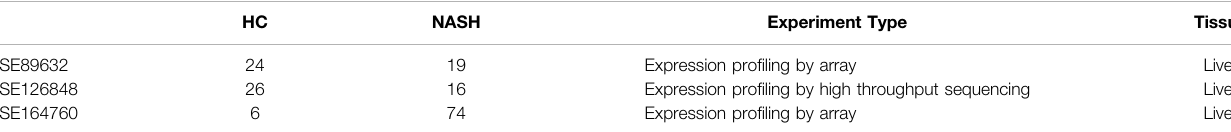
TABLE 1 | Characteristics of the included GEO